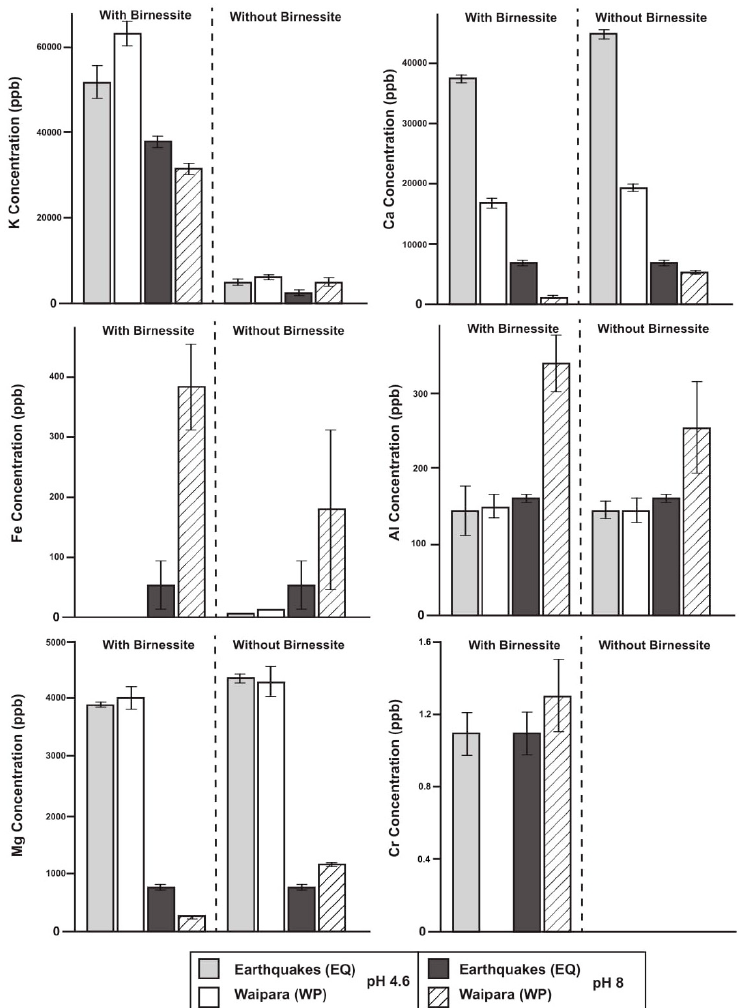
Figure 5. Elemental concentrations of K, Ca, Fe, Al, Mg, and Cr from solubility analysis with and without birnessite conducted at pH 4.6 and 8 on EQ and WP glaucony over a 103 h period. Birnessite decelerates Ca release in both samples at either pH. Glaucony released an average of 1.14 times more Ca without birnessite in the system from EQ (either pH) and W P (pH 4.6) samples